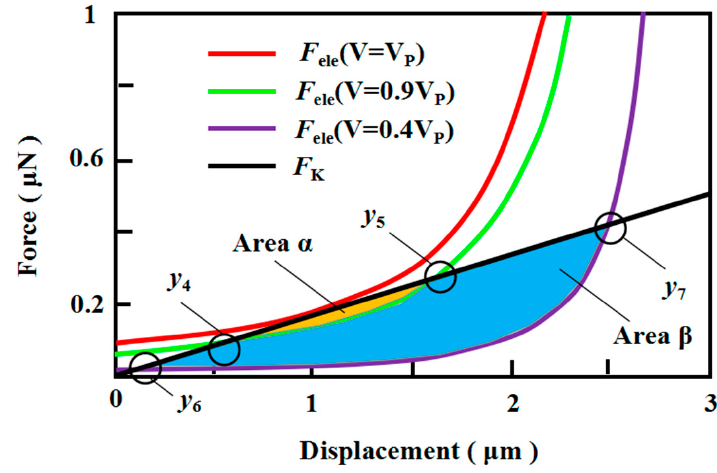
Figure 2. Relationship between electrostatic force and elastic force. By substituting the structural parameters of the inertial switch in Table 1 into Equation (5), those threshold acceleration are obtained and are analyzed, showing that the low voltage allows the detection of high acceleration. Further, these pull-in points, such as y 5 and y 7 in Figure 2, are utilized to achieve fast self-locking of the inertial switch, demonstrating high sensitivity.